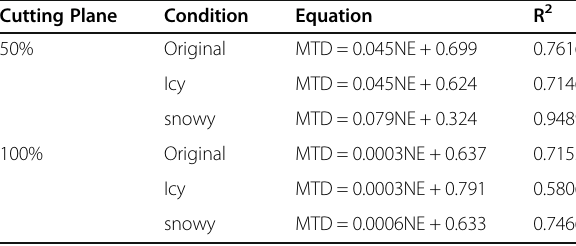
Table 2 Correlation between MTD and NE Cutting Plane